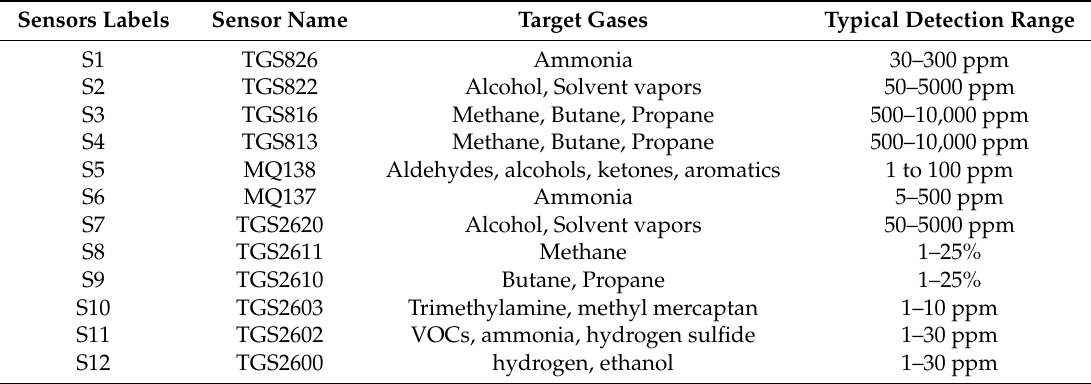
Table 1. The information of the 12 MOS